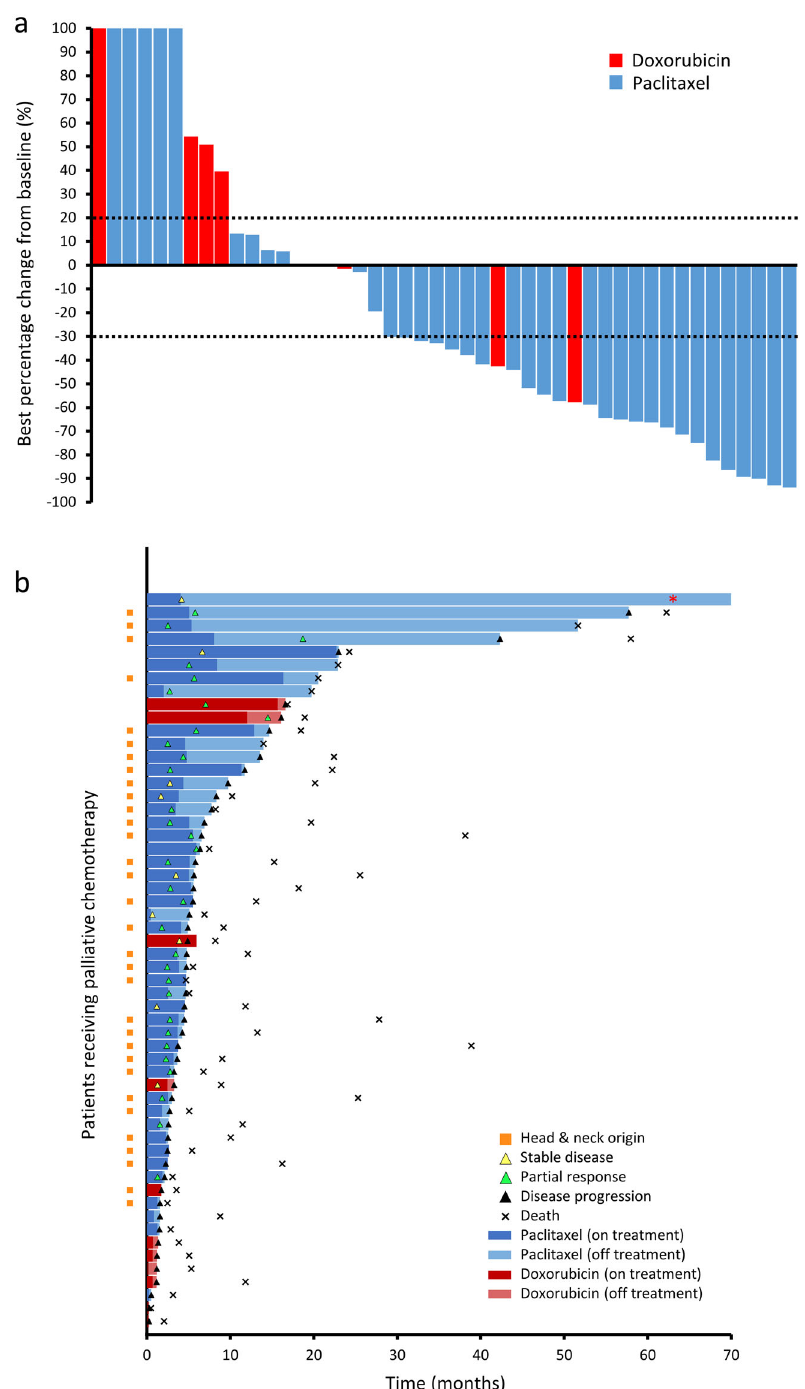
Fig. 3 Response to fi rst-line chemotherapy in angiosarcoma. a First-line chemotherapy resulted in partial responses in 57.4% and stable disease in a further 23.4% of patients. b The median time-to-progression from fi rst-line chemotherapy was 4.8 months (95% CI 3.7 – 6.4 months). Red asterisk: still alive and disease-free at 148